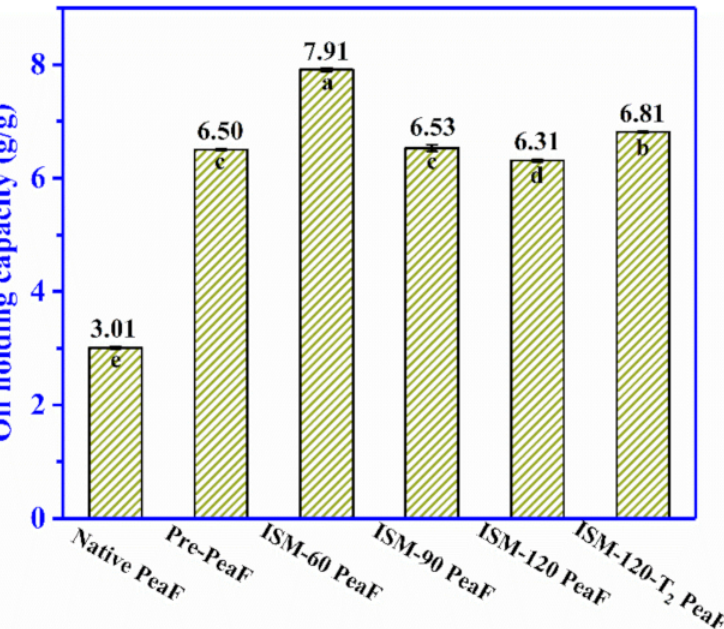
Figure 7. Oil holding capacity of ISMS-treated PeaF. Different letters in Figure 7 indicated significant differences ( p < 0.05) of oil holding capacity between